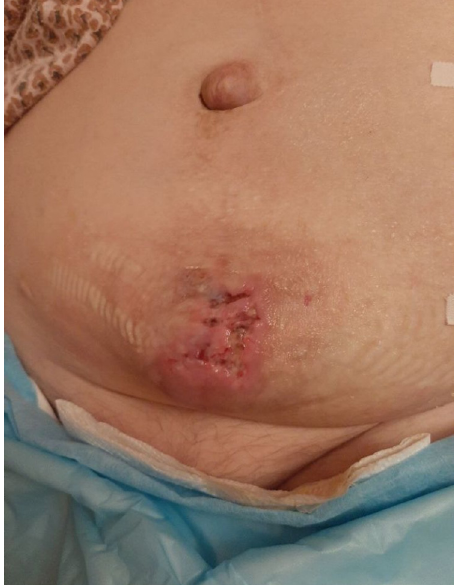
Figure 2: Local condition after PCF